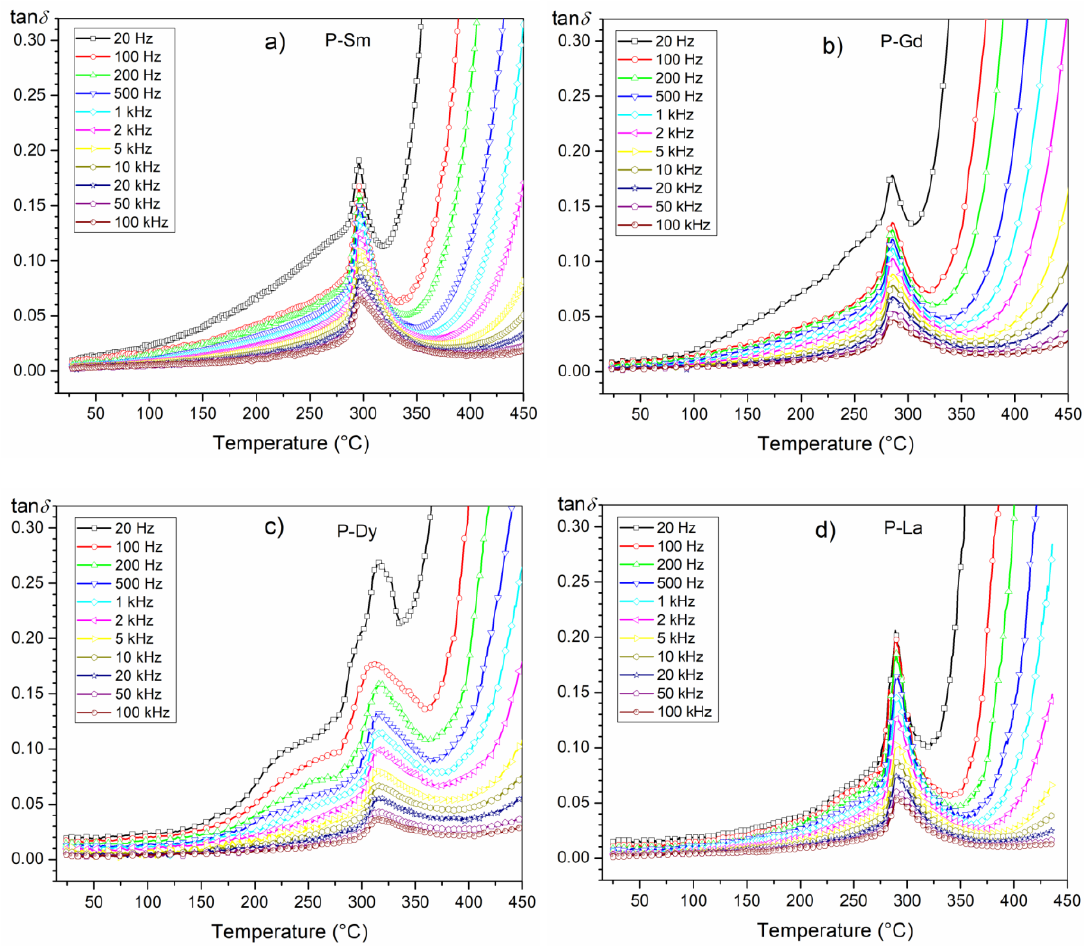
Figure 8. Temperature dependencies of the dielectric loss of the following multicomponent PZT-type samples: ( a ) P-Sm, ( b ) P-Gd, ( c ) P-Dy, ( d ) P-La.